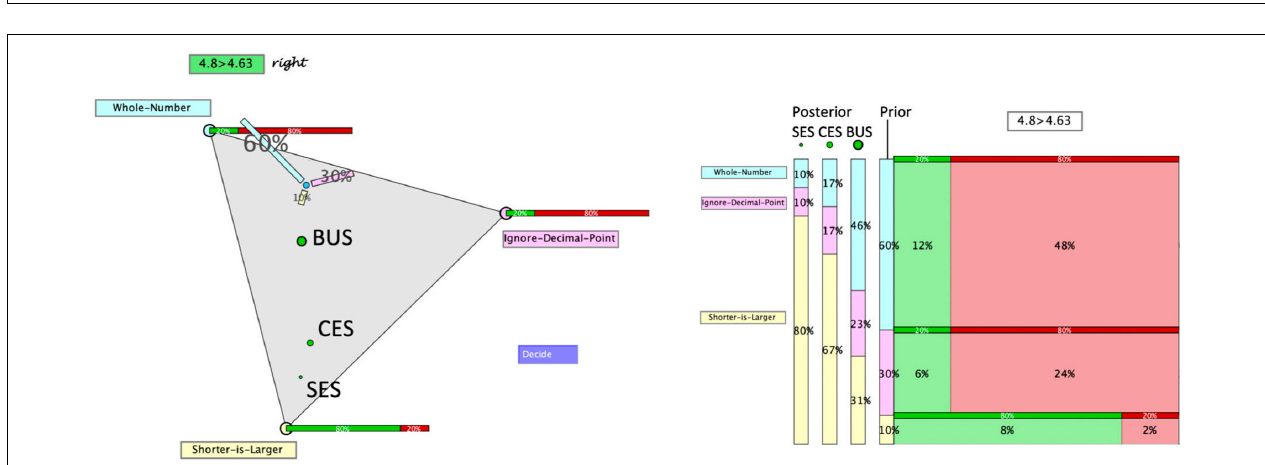
FIGURE 3 | Hypothegon (left hand side) and visualization of update strategies (right hand